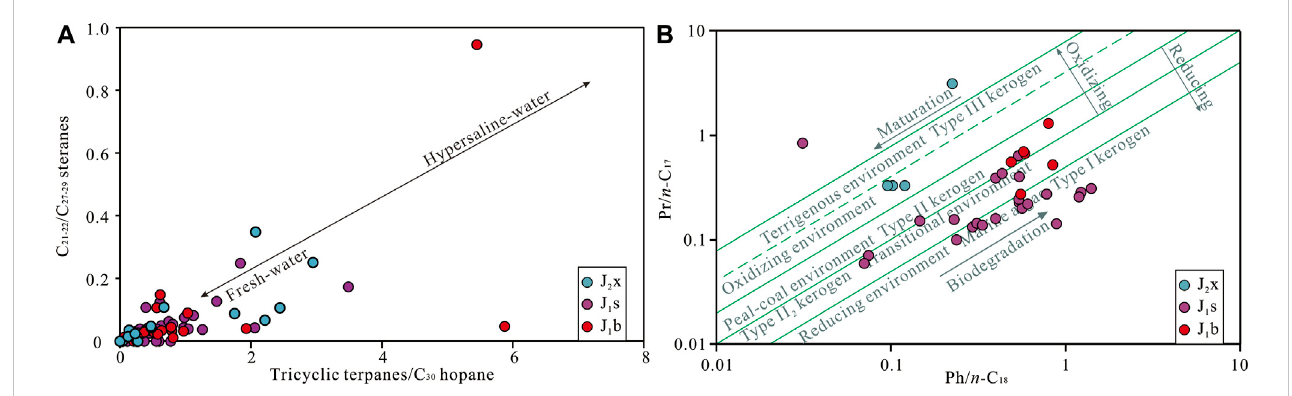
FIGURE 9 (A) Tricyclicterpanes/C 30 hopanevsC 21-22 /C 27-29 steranesand (B) Ph/ n -C 18 vsPr/ n -C 17 (afterShanmugam1985),showingthedepositionalconditionof the Jurassic organic-rich shale in the East Fukang Sag, Junggar Basin,